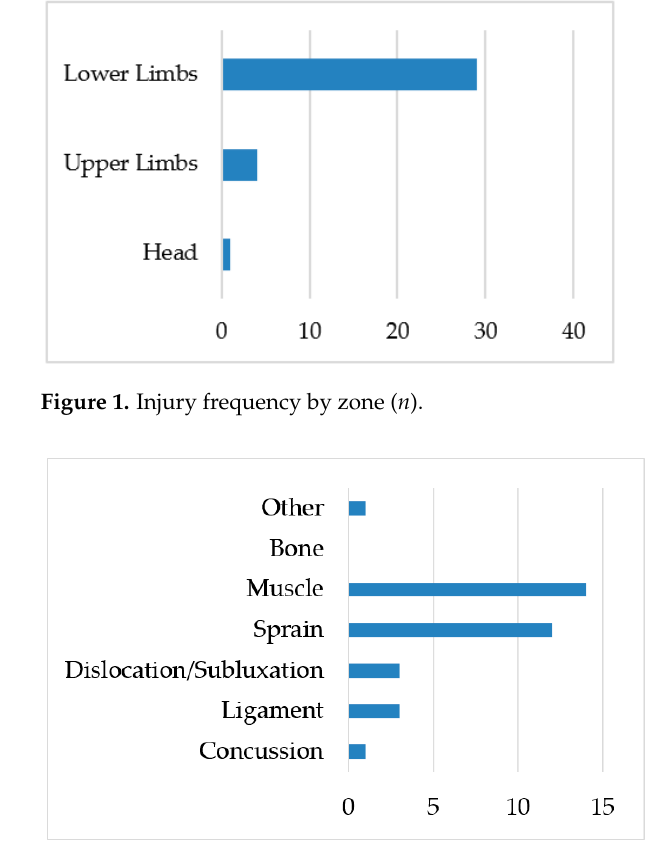
Figure 2. Injury frequency by type ( n ).